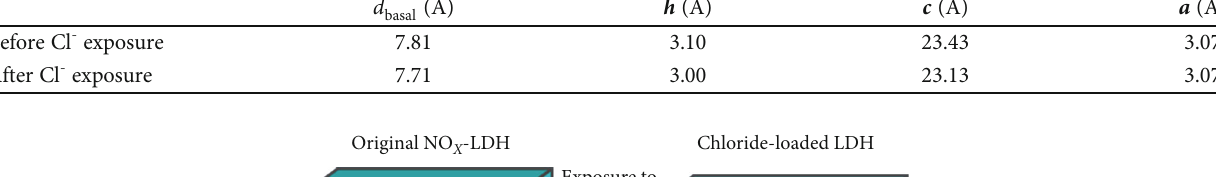
Table 3: Structural parameters calculated for NO